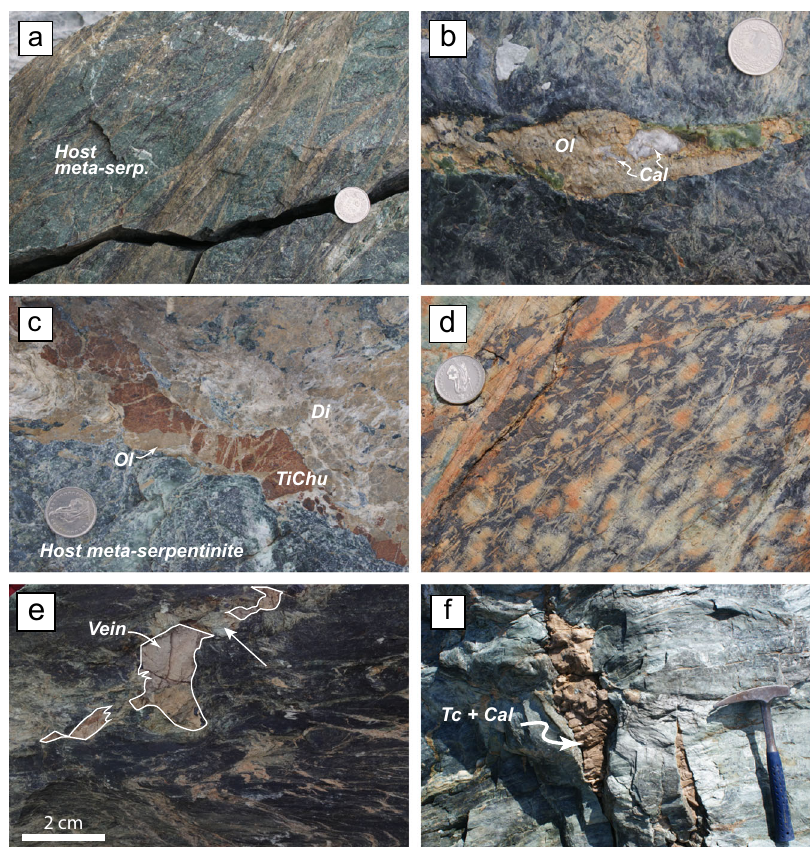
Fig. 2 Field pictures of Zermatt-Saas meta-serpentinites and veins. a Meta-serpentinite showing a dense and anastomosed network of brown metamorphic veins, made of olivine (Ol), diopside (Di), chlorite (Chl), and magnetite (Mag) (sample ZE17-18: host meta-serpentinites) contemporaneous of the main deformation D2. b Sample Trock16-12 showing a pluri centimetric vein fi lled with cm size calcite grain in an olivine (brown) matrix. Late lizardite overgrowing the vein (light green patch below the coin) c Brecciated veins made of Ti-Clinohumite (TiChu), Ol, and calcite with fi brous Di; forming millimeter to centimeter blade. d Sample 11, showing coalescing lath (dendrite) and haloes (spherolite) of olivine (retromorphosed to Serp.) and chlorites in a black matrix made of Atg. e Ol-TiChu-Cal vein dissected and boudinaged by a late D3 deformation. White arrow points to fi brous chrysotile growing in the boudin ’ s neck. f Tension gashes made of talc (Tc) and calcite (Sample ZE17-09) crosscutting the main serpentinite